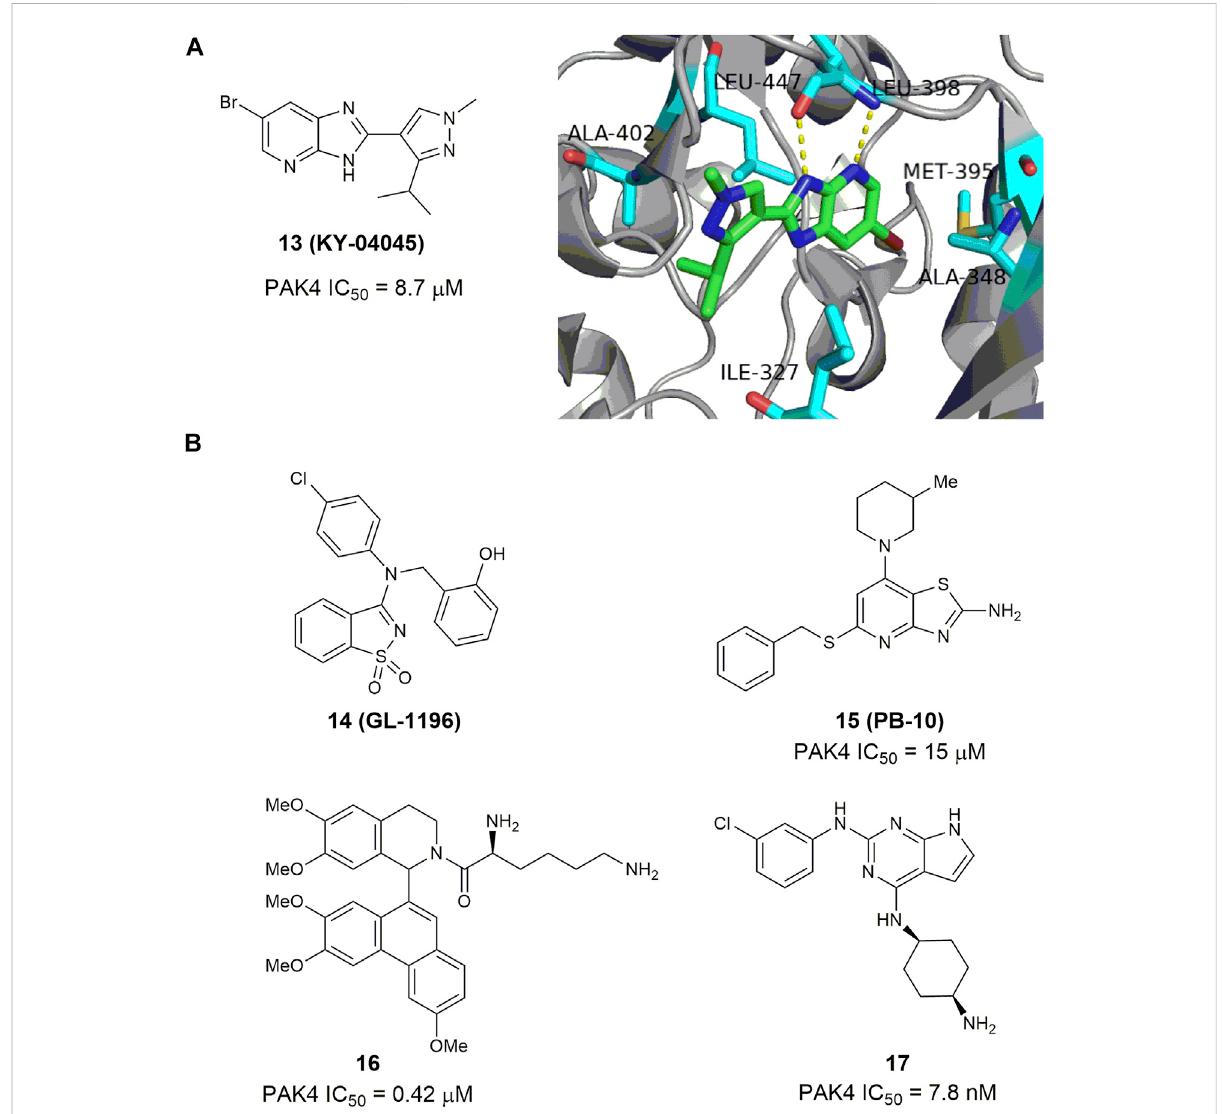
FIGURE 8 (A) The structure of compound 13 and its crystal structure in complex with PAK4 (PDB code: 5I0B). (B) The structure and activity of bicyclic PAK4 inhibitors 14 –